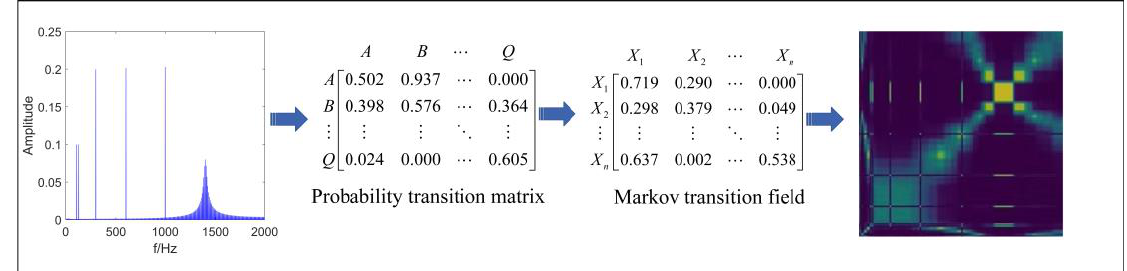
Figure 1. The flowchart of MTF.